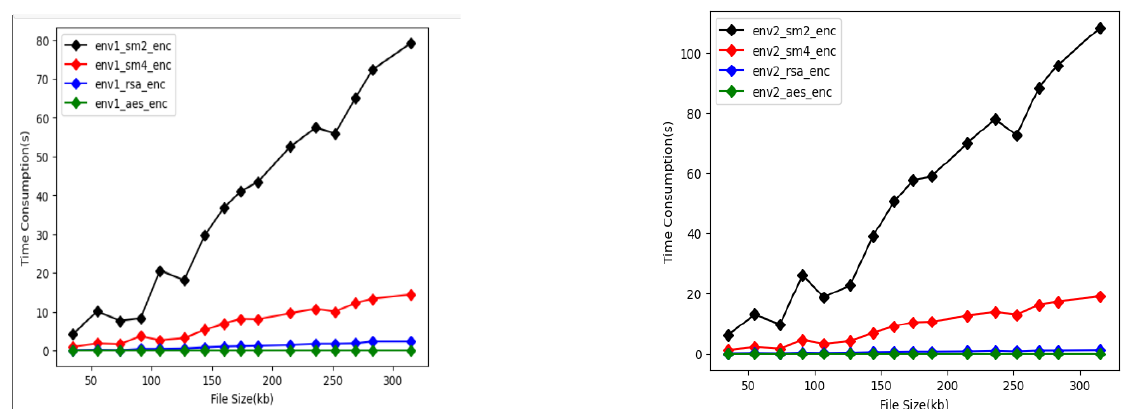
Figure 10. Time consumption for simulating transmission public keys to DRC using SM2, SM4, AES, and RSA in env-1 ( a ) and env-2( b ).